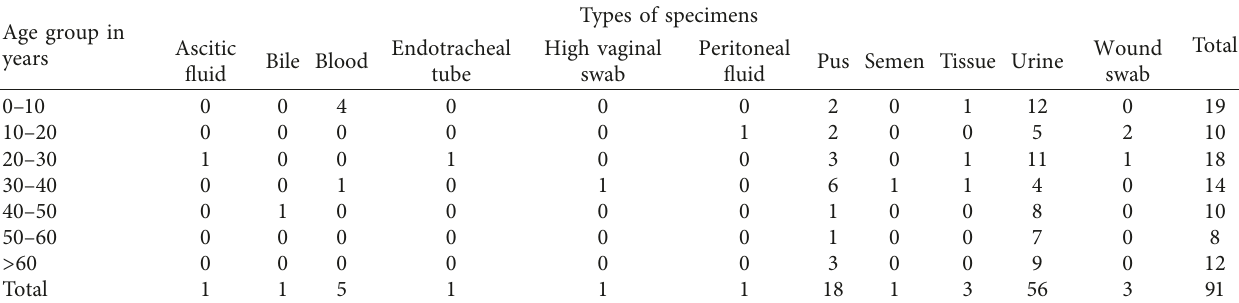
Table 1: Nature of specimens recovered from different age groups.